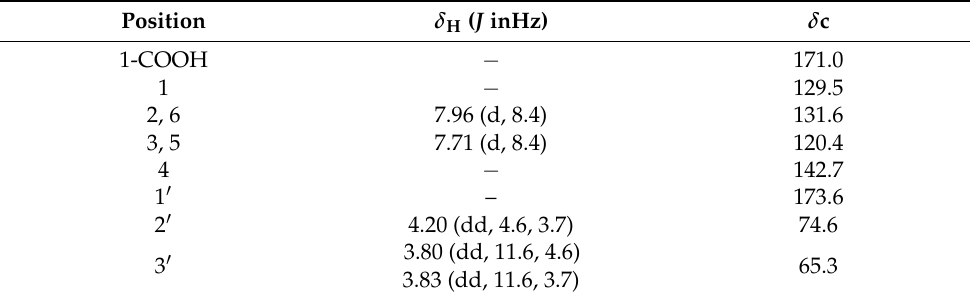
Table 1. 1 H and 13 C NMR Data for 1 in CD 3